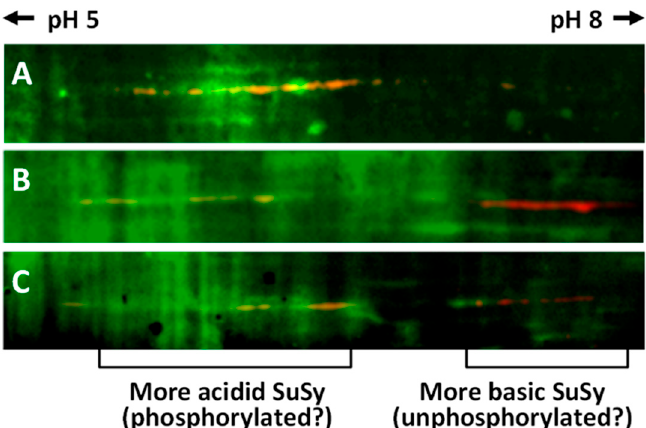
Figure 7. Phosphoprotein staining and western blotting with anti-sus-1 antibody after separation of proteins by two-dimensional electrophoresis with a pH gradient of 5–8. ( A ) Cytosol proteins. ( B ) Membrane proteins. ( C ) Cell wall proteins. The images are merged from the two analyses. The phosphoproteins are shown in green, while the SuSy signal is shown in red. Where the red color turns to orange-yellow, this represents alignment of phosphoproteins and SuSy.